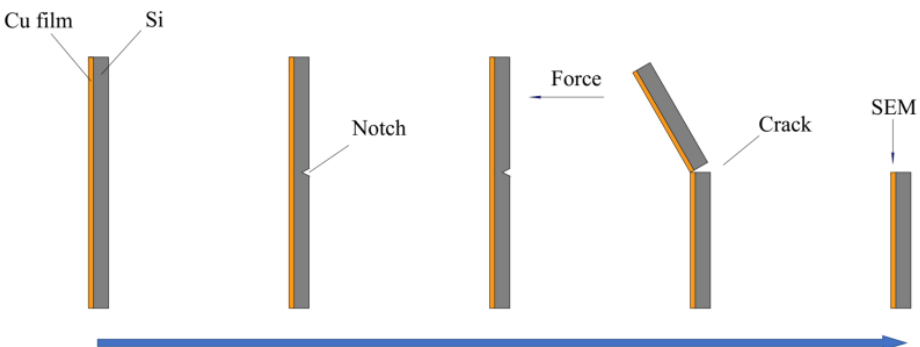
Figure 3. Coating cross-section sampling process for SEM